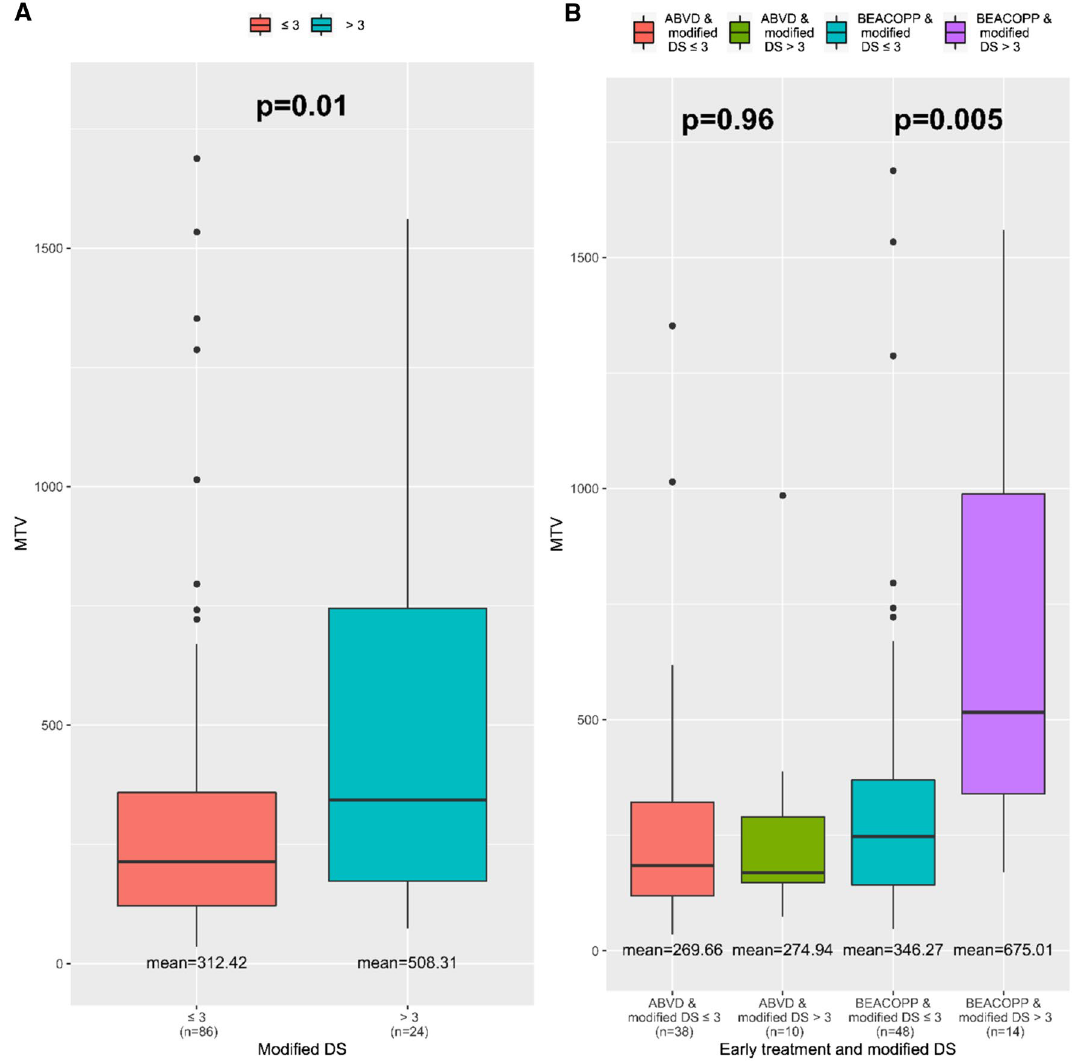
Figure 4. Prognostic value of total metabolic tumour volume (TMTV) for 2-cycle PET scan response according to modified Deauville score.